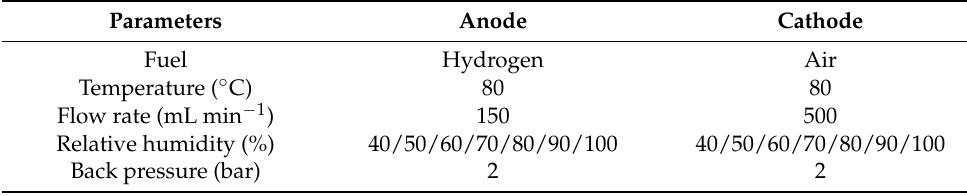
Table 1. MEA test conditions in the PEMFC single